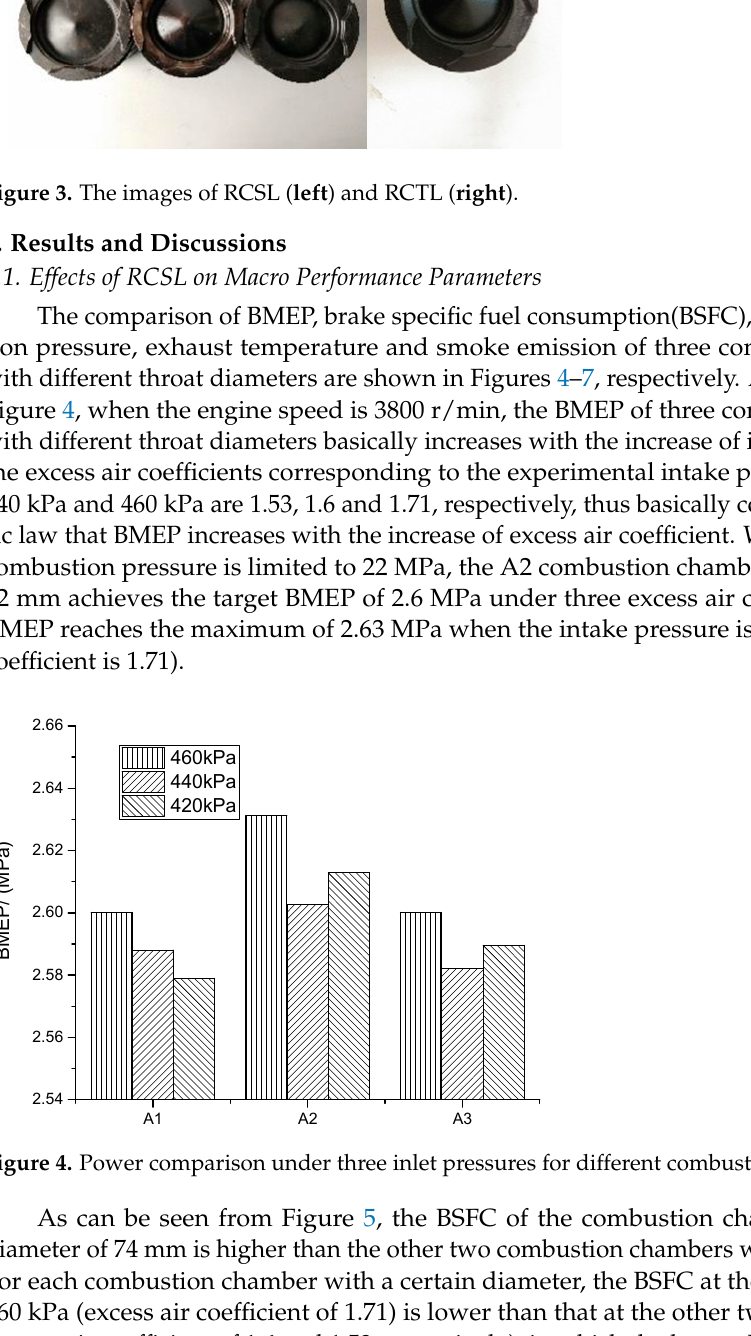
Figure 5. Comparison of BSFC under three inlet pressures for different combustion chambers. It can be seen from Figure 6 that the exhaust temperature of the three combustion chambers are less than 750 °C, which meets the limit requirements of the highly intensi- fied diesel engine for exhaust temperature. For each combustion chamber diameter, the exhaust temperature increases monotonically with the decrease of intake pressure (and the decrease of excess air coefficient), which is caused by the increase of after-burning